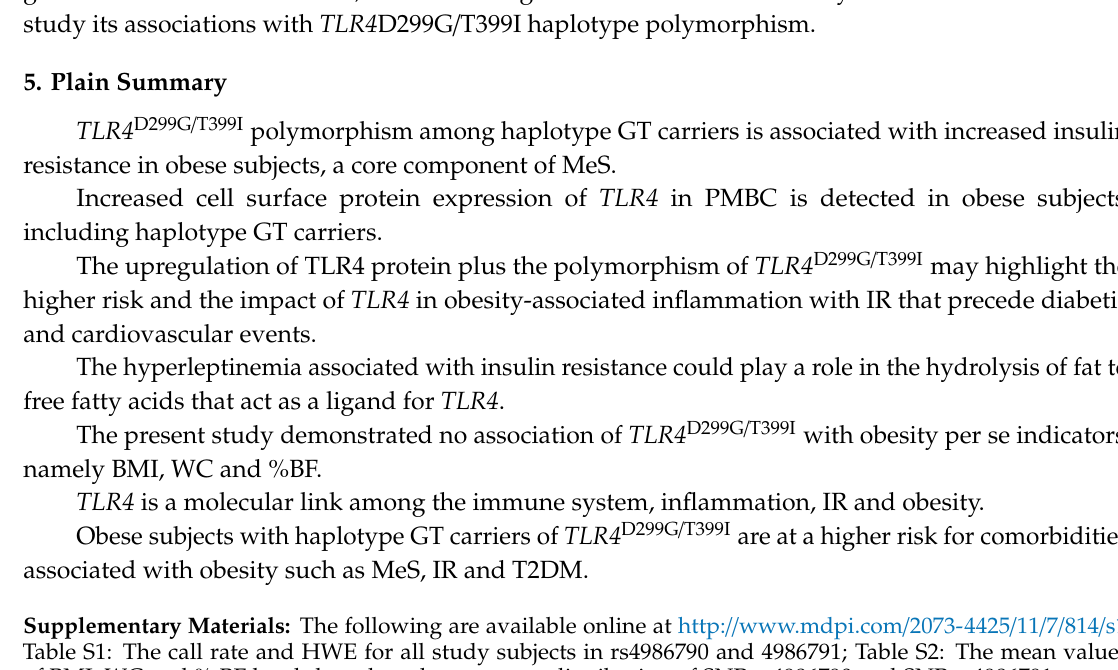
Table S1: The call rate and HWE for all study subjects in rs4986790 and 4986791; Table S2: The mean values of BMI, WC and % BF levels based on the genotype distribution of SNP rs4986790 and SNP rs4986791 among the study subjects; Table S3: The association between obesity as the dependent variable with the following